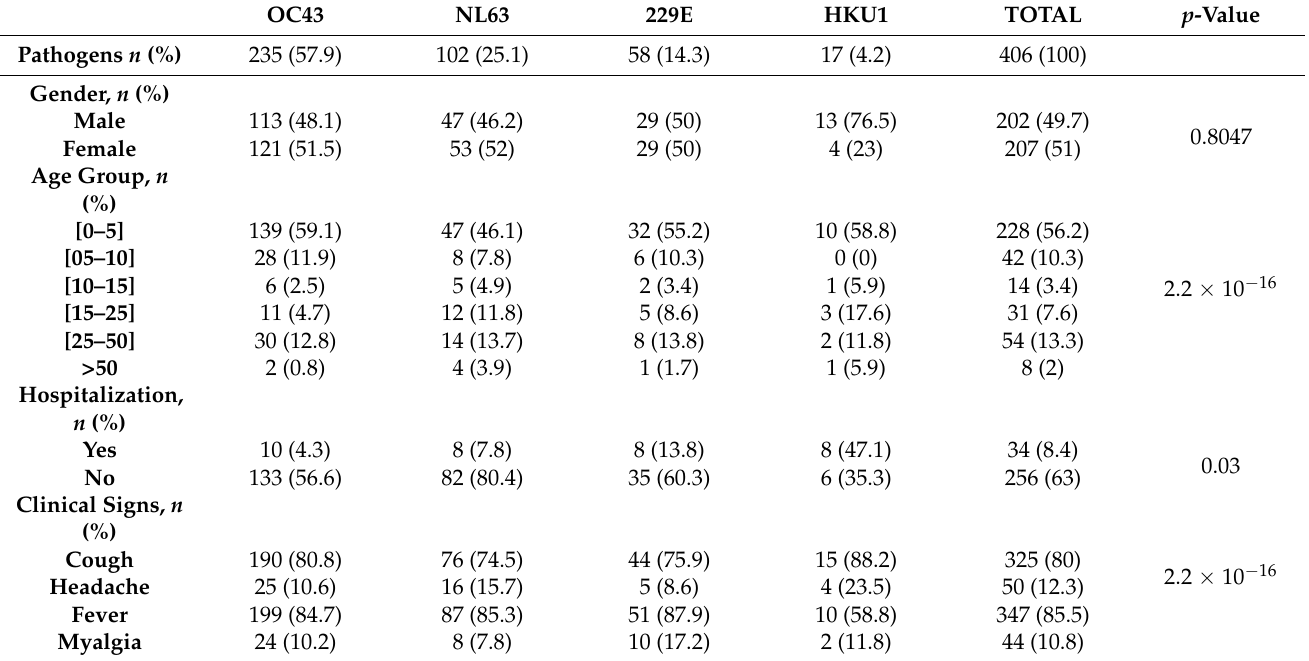
Table 2. Clinical and demographic characteristics of HCoV positive patients in Senegal,